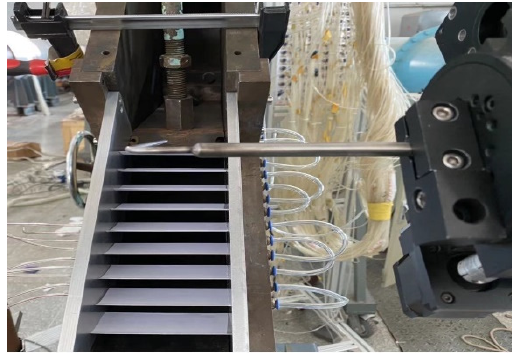
Figure 7. Test section with microgroove polyurethane coatings.